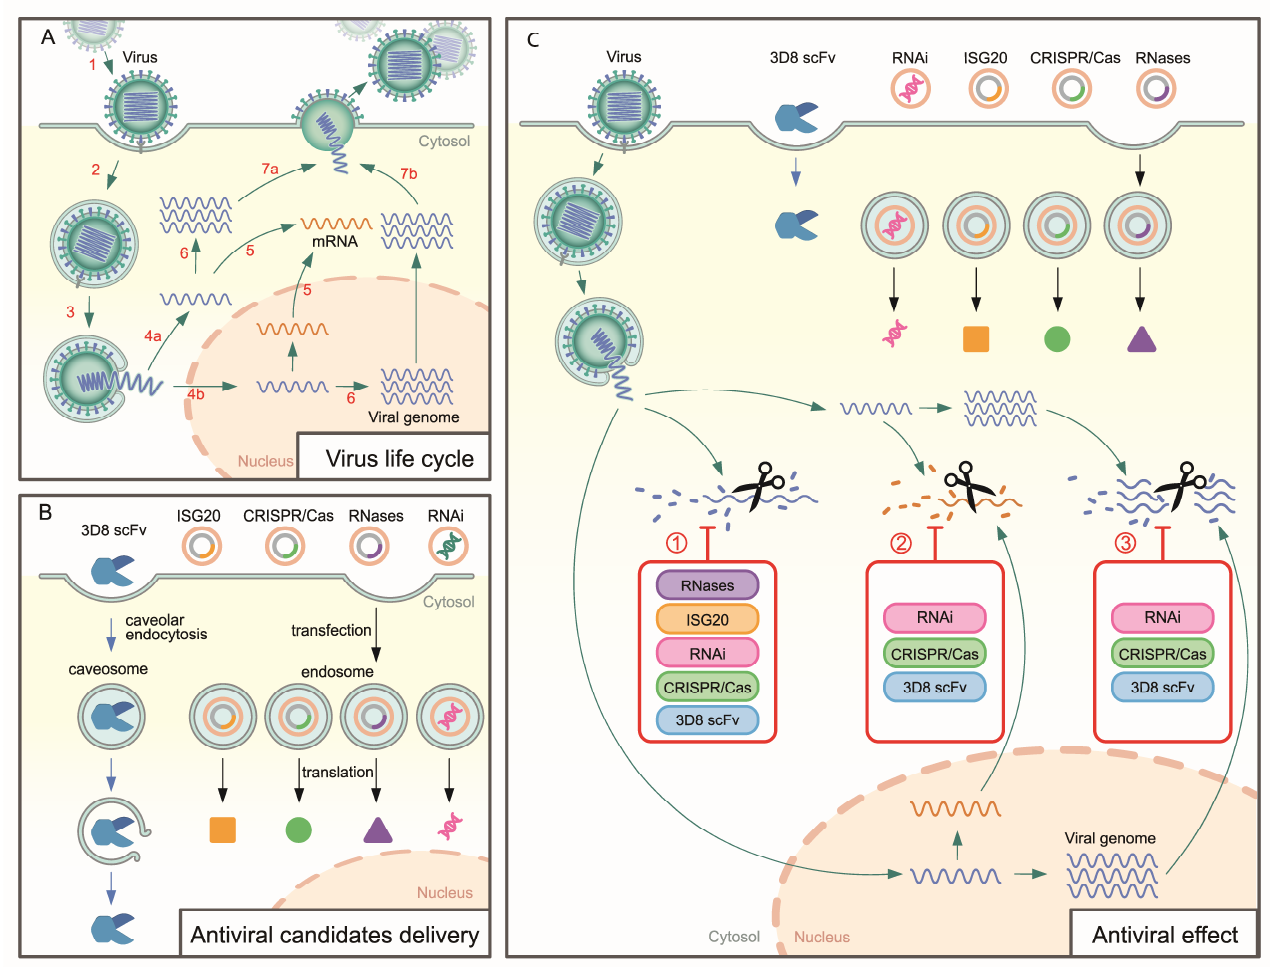
Figure 1. Proposed mechanism of viral genome degradation-specific antiviral candidates. ( A ) Typical viral life cycle of enveloped viruses; virus infection to host cells includes several main steps, 1. Binding; 2. Fusion; 3. Release of viral genome in the cytoplasm; 4a. Replication in the cytoplasmic or 4b in the nucleus (viral genome needs to be transported to the nucleus), 5. Transcription and presence of mRNA in the cytoplasm for translation; 6. Viral genome replication; 7a, 7b. Assembly and release of new virions. ( B ) 3D8 scFv with cell penetration ability via caveolar endocytosis and localization in the cytoplasm, intracellular localization of other candidates (CRISPR/Cas, ISG20, RNases, and RNAi) are proposed with a delivery system and expressed as protein inside the cells. ( C ) The presence of viral genomes cleavage candidates (3D8 scFv, CRISPR/Cas, ISG20, RNases, RNAi) inhibits viral replication. Upon infection, viral genomes distributed in the cytoplasm were digested by RNase, ISG20, CRISPR/Cas, 3D8 scFv, and RNAi. 3D8 scFv, RNAi, and CRISPR/Cas were supposed to degrade viral mRNA in the cytoplasm for translation. Finally, the replicated viral genomes can be catalyzed using 3D8 scFv, RNAi, and CRISPR/Cas.